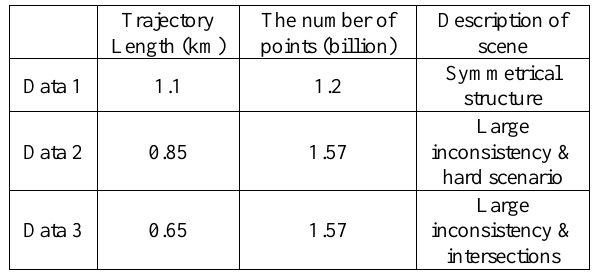
Table 1. MLS point cloud information.